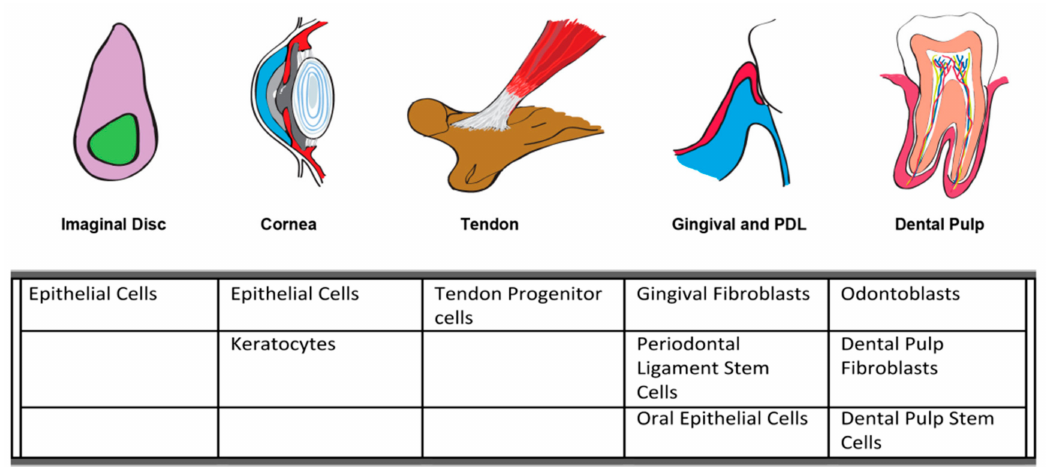
Figure 5. Summary of cell types in which JNK signaling plays a role in soft connective